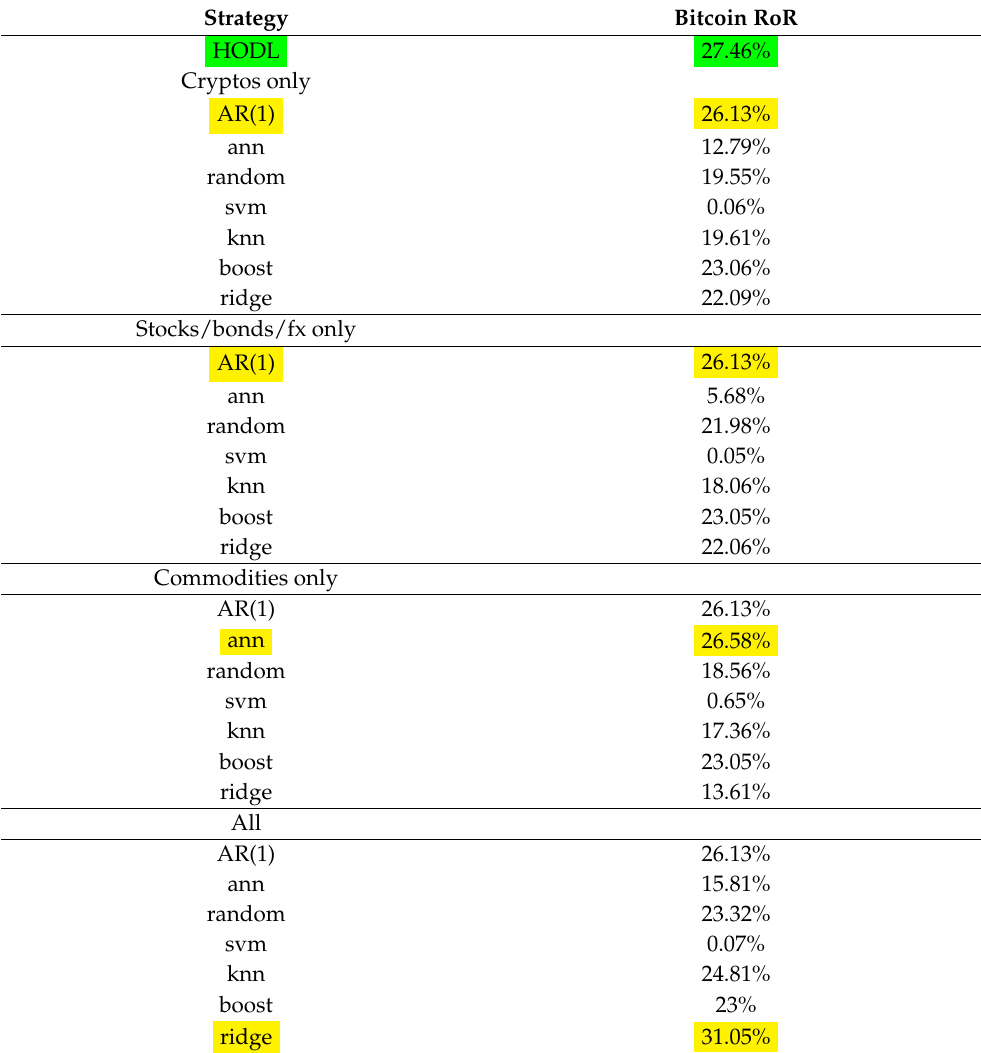
Table 16. Sensitivity Analysis for Bitcoin Rate of Return (RoR) of ML algorithms against the HODL strategy. Strategy Bitcoin RoR